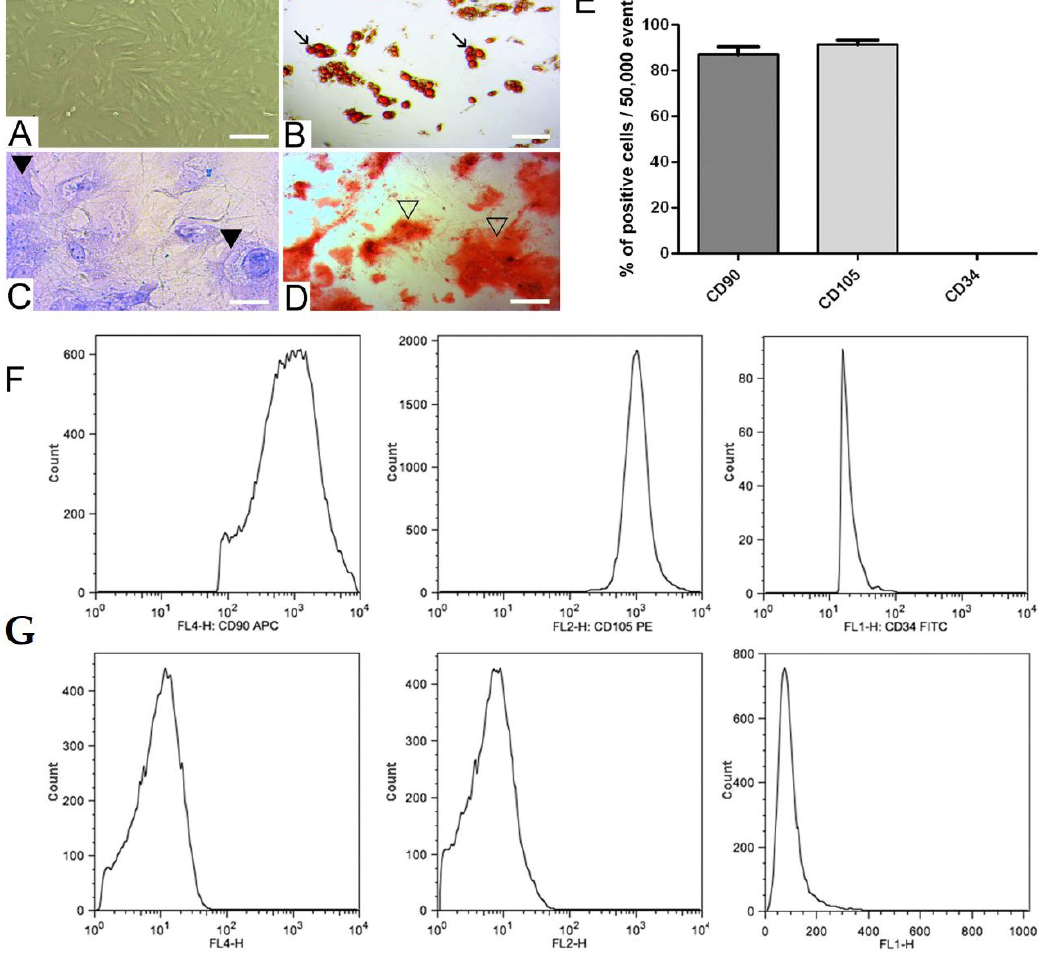
Figure 1. In vitro di ff erentiation potential of ASC ( n = 4) in 5P ( A ): adipogenic ( B ) and lipid stained with Sudan IV ( → ); chondrogenic ( C ) and proteoglycans stained with toluidine blue ( (cid:183) ); osteogenic ( D ) (cid:46) and calcium stained with alizarin red ( ). Di ff erent cells were stained after 4 weeks of culture. ( E ) Flow cytometry for ASC in 5P ( n = 4) with positive labeling for CD90 and CD105 and negative labeling for CD34. ( F ) Histograms demonstrate the x-axis fluorescence scale considered positive when the cell peak is above 101 (CD34) or 102 (CD90 and CD105). ( G ) Control for -APC, -PE and -FITC (with very low fluorescence), corresponding to non-marked cells. Bars = A, B, D: 120 µ m; C: 40 µ